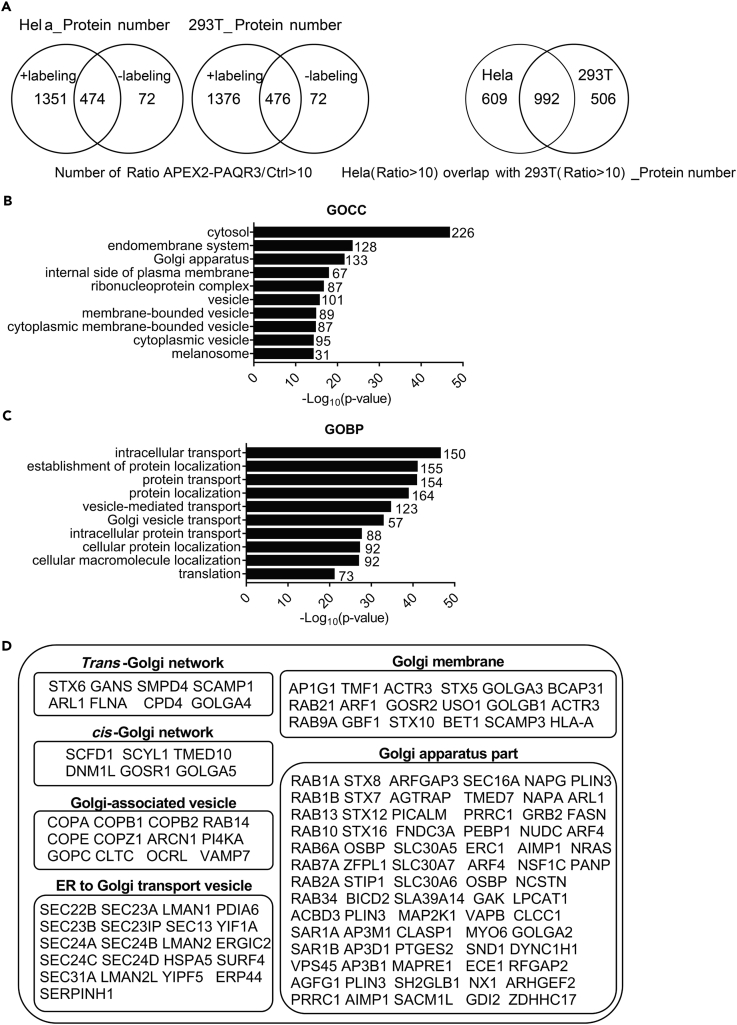
Identification of Proteins from Proximity Labeling with APEX2-PAQR3(A) Venn diagram showing identified proteins after streptavidin chromatography from APEX labeling (+labeling) or mock labeling (without H2O2, -labeling) in HeLa cells and HEK293T cells. The right panel shows the proteins found in both cell types. The experiment was repeated three times with similar results.(B) Going analysis of cellular compartment (GOCC) of the 992 candidate proteins found in both HeLa and HEK293K cells.(C) Going analysis of biological process (GOBP) of the 992 candidate proteins found in both cell types.(D) A list of Golgi- and trafficking-associated proteins labeled by APEX2-PAQR3 in both cell types.